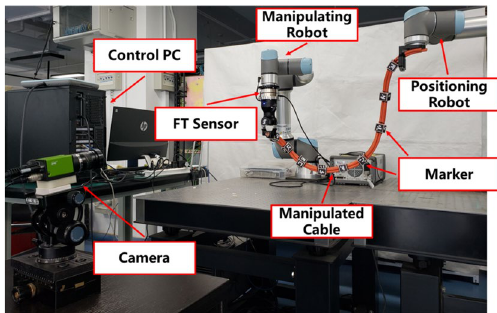
Figure 7. The illustration of our experimental system.